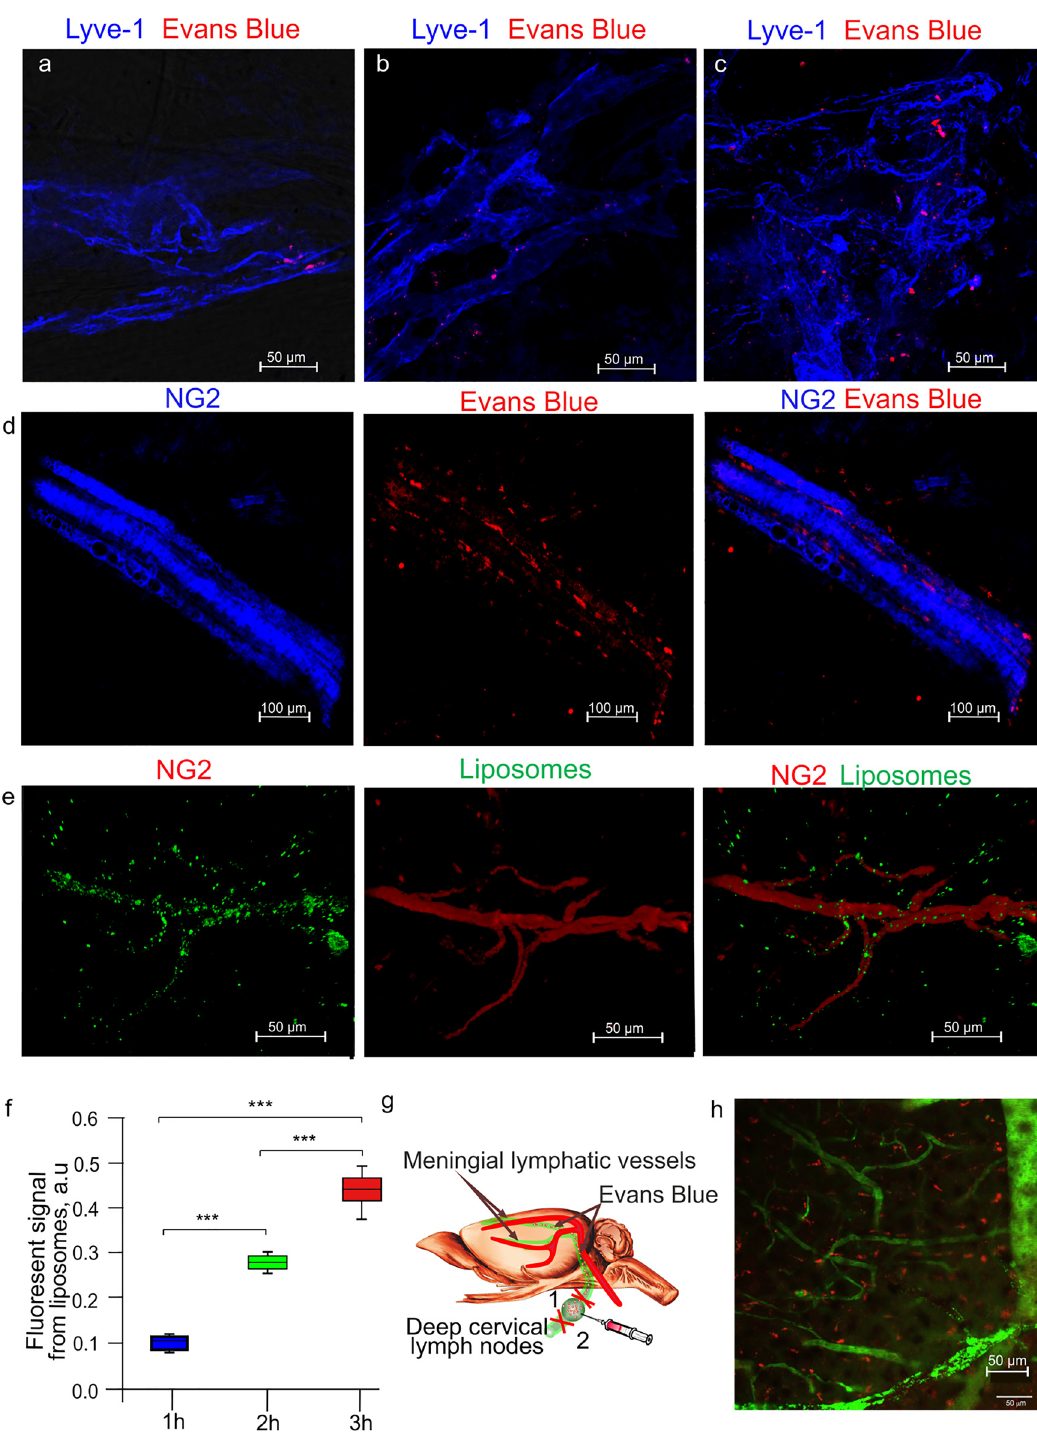
Figure 1: The lymphatic backroad to the brain: a – c – Representative images of the distribution of Evans Blue in the meninges labeled with Lyve-1 in rats 1 h (a), 2 h (b), and 3 h (c) after the dye injection in dcLN; d – Representative images of the presence of Evans Blue along the meningeal blood vessels labeled with marker of pericytes (neuron-glial antigen 2 – NG2) 3 h after its injection in dcLN; e – Representative images of the presence of liposomes along the meningeal blood vessels labeling with NG2 3 h after its injection in dcLN; f – Quantitative analysis of the signal intensity from Evans Blue in the meninges 1, 2, and 3 h after the dye injection in dcLN, *** p < 0.001 between groups at t = 1, 2, and 3 h after the dye injection, n = 7 in each time point; g – Schematic illustration of the cervical LVs for the study of lymphatic pathways of dye delivery from dcLN; h – Real-time confocal imaging of the retrograde lymphatic pathway of Evans Blue delivery to the meninges 3 h after dye injection in dcLN and ligation of the cervical LVs below